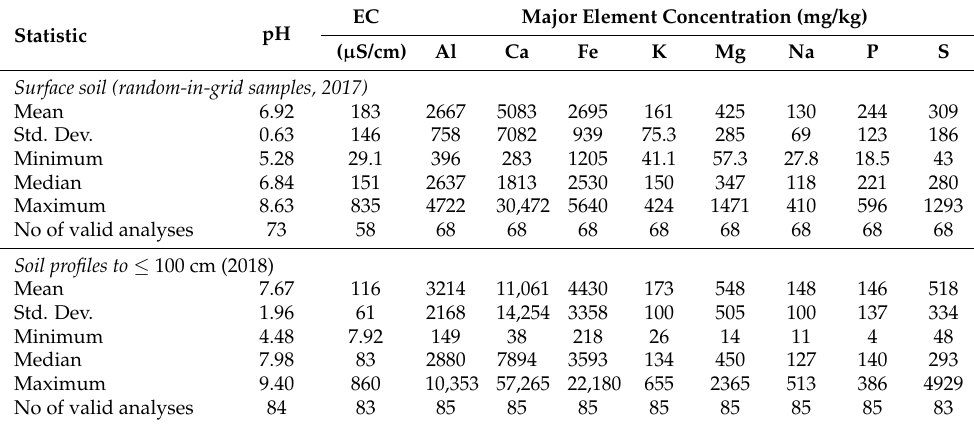
(Mg), manganese (Mn), neodymium (Nd), nickel (Ni), phosphorus (P), lead (Pb), sulfur (S), strontium (Sr), and zinc (Zn) all had maximum/minimum ratios between 20 and 90. Soluble salt content measured by EC showed a maximum/minimum ratio of ≈ 29, and there was a relatively large, ≈ 3.4 units range in pH across the Reserves. Except for zinc, which exceeded the interim Ecological Investigation Level (EIL; National Environment Protection Council, 1999) in three samples, no other soil thresholds were exceeded by any element (Table 2). Table 1. Summary of pH, EC, and major element concentrations in surface (0–10 cm) soil and in vertical soil profile samples at Smith’s Lake and Charles Veryard Reserves. EC and pH were measured in 1:5 solid: deionised water suspensions; element concentrations were measured using aqua regia digestion followed by ICP-OES. Statistic Surface soil (random-in-grid samples, 2017) Mean